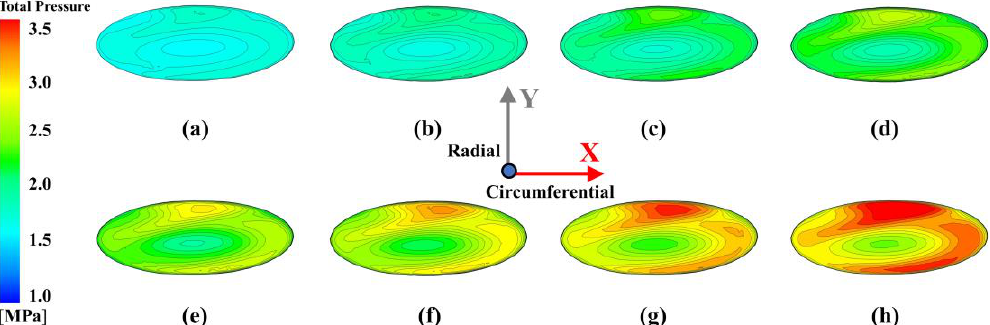
Figure 9. Distribution of total pressure at the middle section in the pre-swirl nozzle at Re = 9.5172 × 10 5 with different nozzle pressure: ( a ) −30% design pressure, ( b ) −20% design pressure, ( c ) −10% design pressure, ( d ) -design pressure, ( e ) +10% design pressure, ( f ) +20% design pressure, ( g ) +30% design pressure, and ( h ) +40% design pressure.